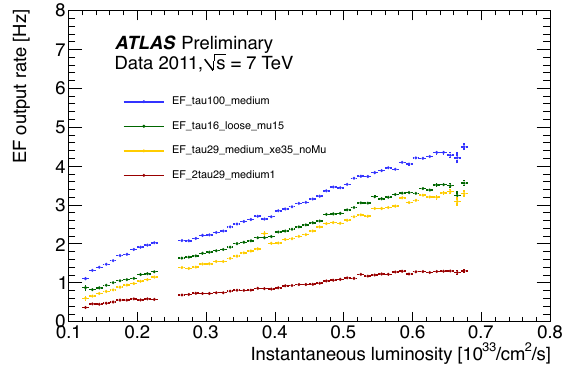
Fig. 6. Evolution of the event rate as a function of the instanta- neous luminosity for EF items as measured in 2011 data